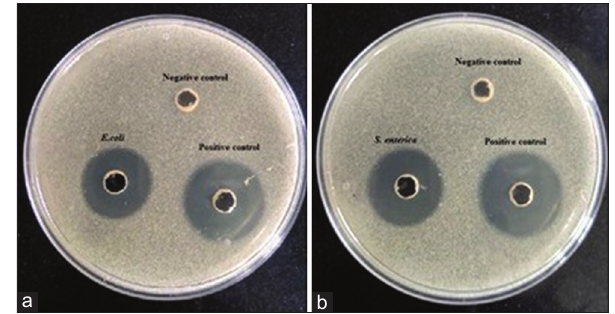
Figure-6: Antimicrobial activity testing of 5×concentrated cell-free extract of S. bovis against (a) Escherichia coli and (b) Salmonella enterica using agar diffusion assay . Streptomycin and nutrient broth have been used as positive and negative control, respectively.